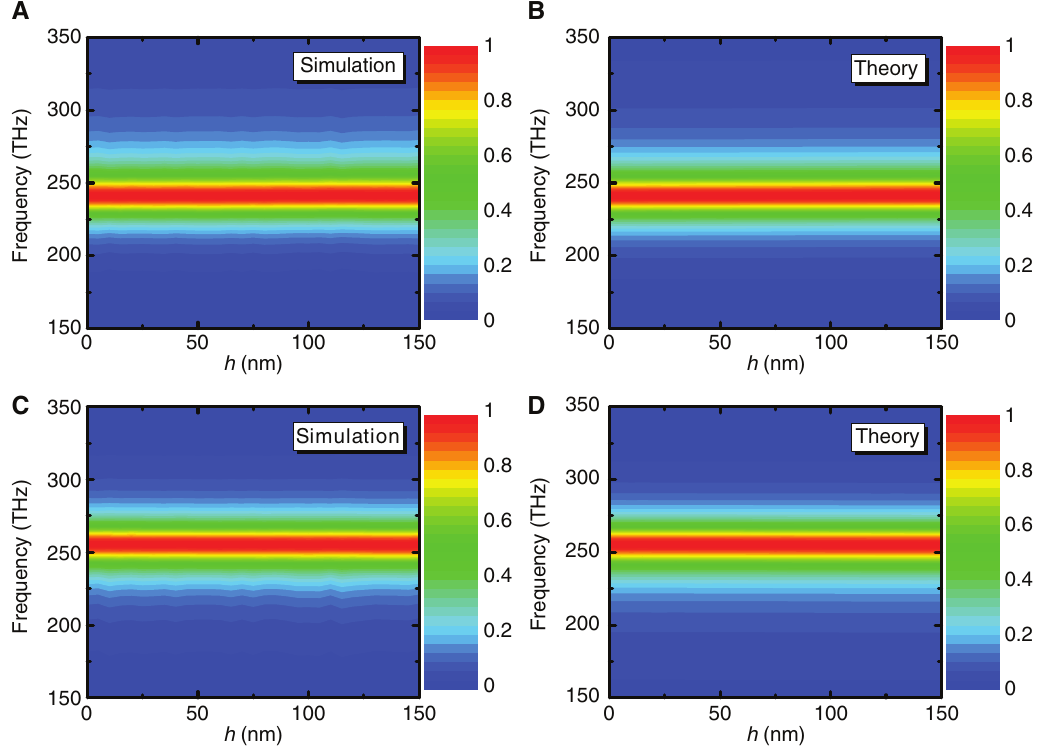
Figure 7: The spectrum of PC-SCPA of the designed optical system possessing the phase coupling as a function of the vertical spacing distance h for antisymmetric and symmetric incidences, respectively. (A) and (C) are simulation results for antisymmetric and symmetric incidences, respectively. (B) and (D) are theoretical results for antisymmetric and symmetric incidences,